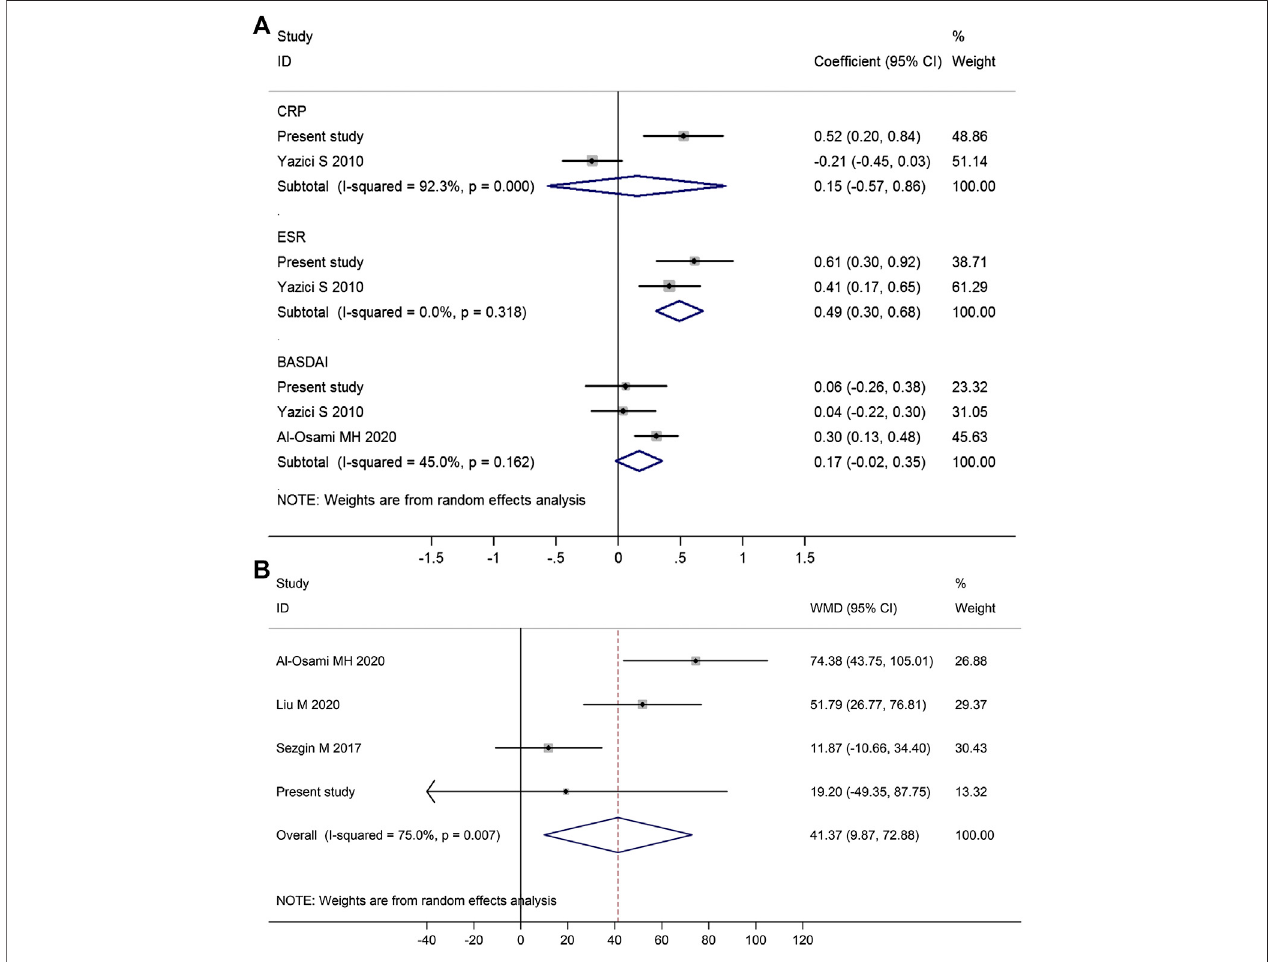
FIGURE 3 | Forest plot in the meta-analysis of the correlations between platelet count and disease activity markers in AS patients. (Meta-analysis suggested that platelet count was positively associated with ESR but not BASDAI score or CRP (A) , and AS patients with high disease activity (BASDAI ≥ 4) had signi fi cantly higher platelet count than those with low disease activity (BASDAI < 4) (B) . WMD, weighted mean difference; 95% CI, 95% con fi dence interval. Coef fi cient represents the correlation coef fi cient between platelet count and disease activity parameters. The diamond represents the pooled correlation coef fi cient, and its left and right vertices represent the 95%